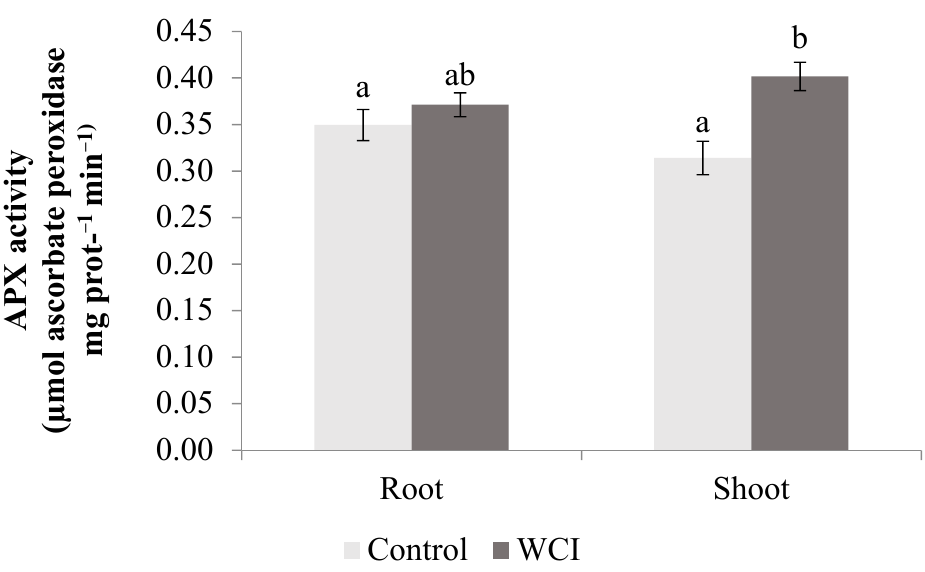
Figure 6. The effect of woolly cupgrass infestation (WCI) on the APX activity of maize 21 d.a.s. (values are means ± SD, n = 5). Small letters (a, b) show significant differences between treatments based on independent t -test ( p < 0.05).